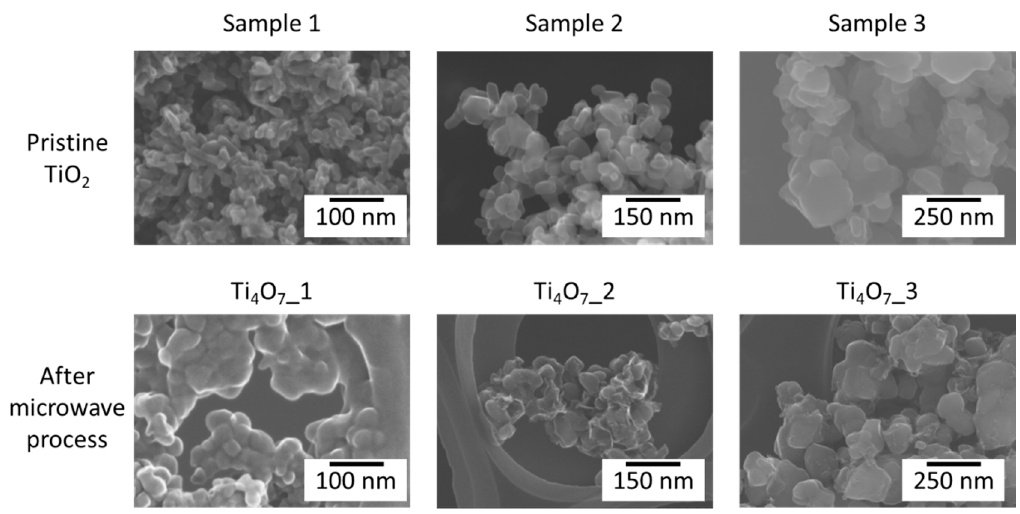
Figure 4. FE-SEM (field emission scanning electron microscope) images of pristine TiO 2 and synthesized Ti 4 O 7 nanoparticles acquired in secondary electron (SE) mode.